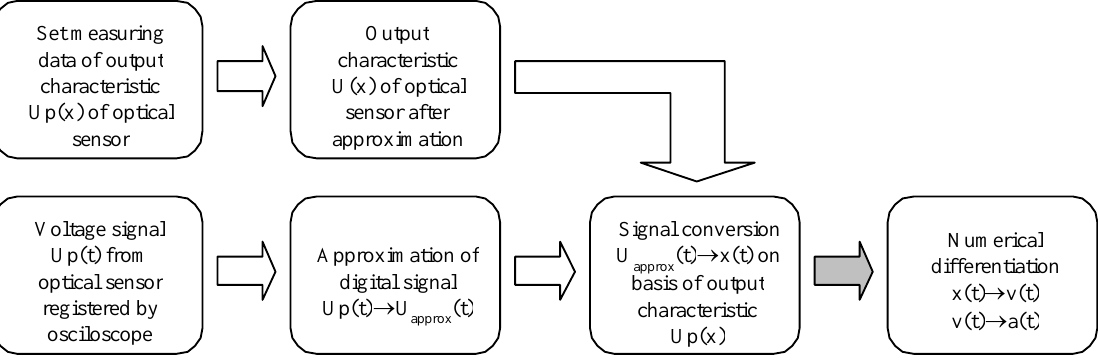
Figure 5. ( a ) The output characteristic of the optical sensor (measurement and approximation); ( b ) the mean square error and the relative error in function ( k r = n ) of the number of measuring points taken into account.